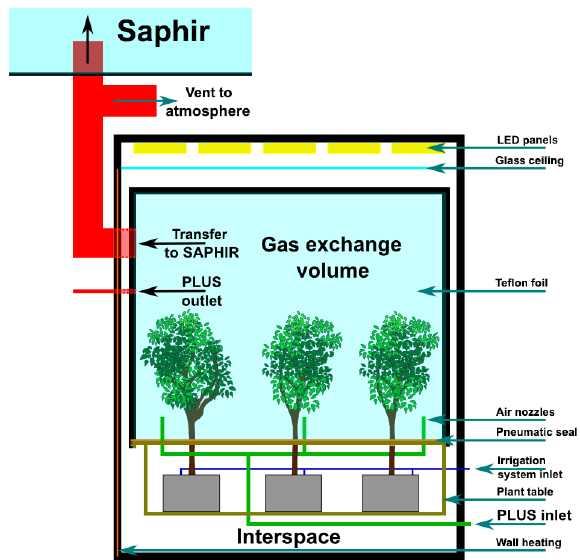
Figure 1. Schematic diagram of the PLUS plant container. The green lines show the inflow of synthetic air and other gases into PLUS (PLUS inlet) and the red lines are the outflows of PLUS to either instrumentation (PLUS outlet), SAPHIR or the